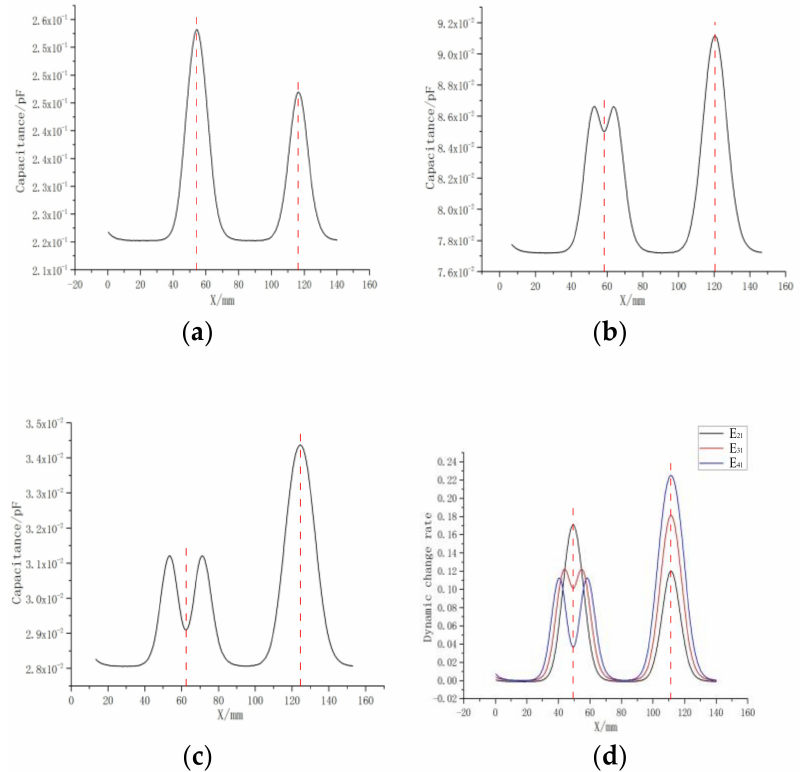
Figure 6. Test results: ( a ) the capacitances of E21, ( b ) the capacitances of E31, ( c ) the capacitances of E41, ( d ) the DCRs of E21, E31 and E41; DCRs: Dynamic Change